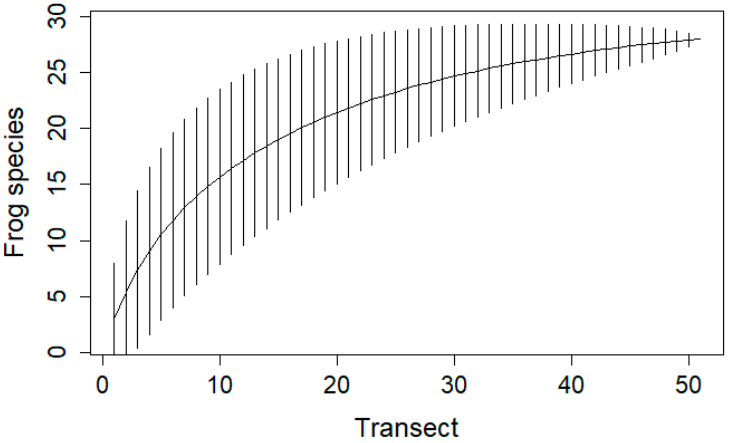
Figure 7. Species accumulation (rarefaction) curve (solid line) plotted against survey effort (number of transects surveyed) and vertical lines represent 95% confidence intervals.